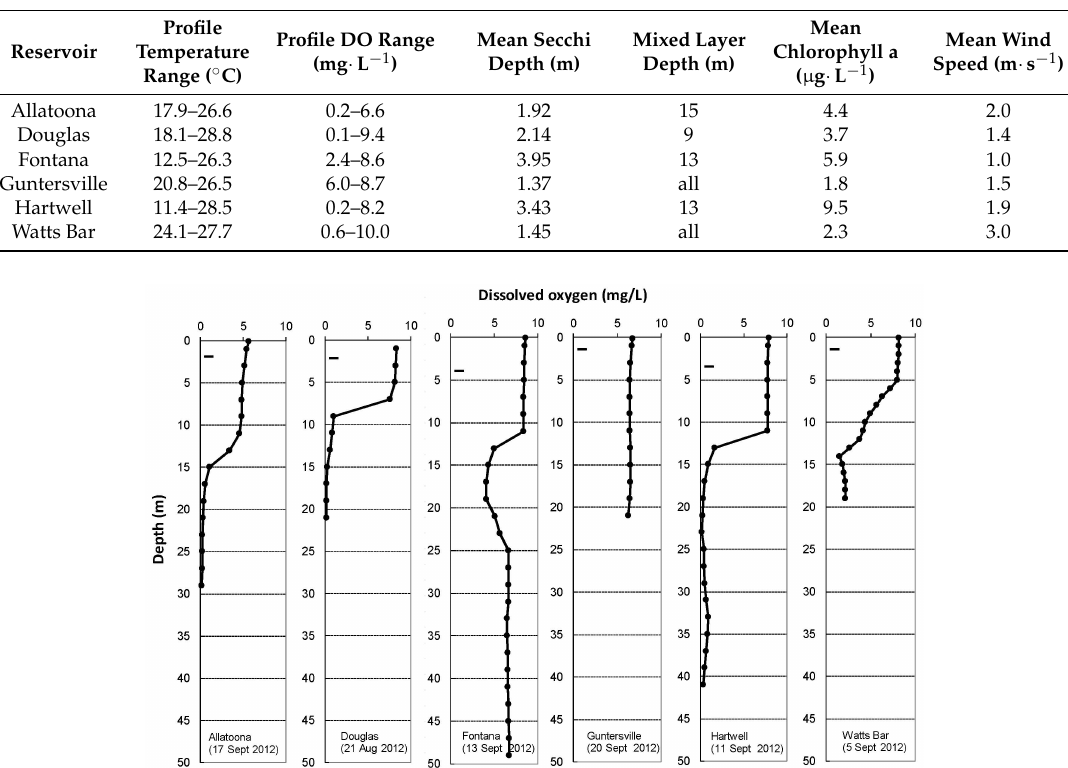
Table 2. Water quality measures and mean wind speed during sampling of gas emissions at six hydropower reservoirs in the southeastern U.S.